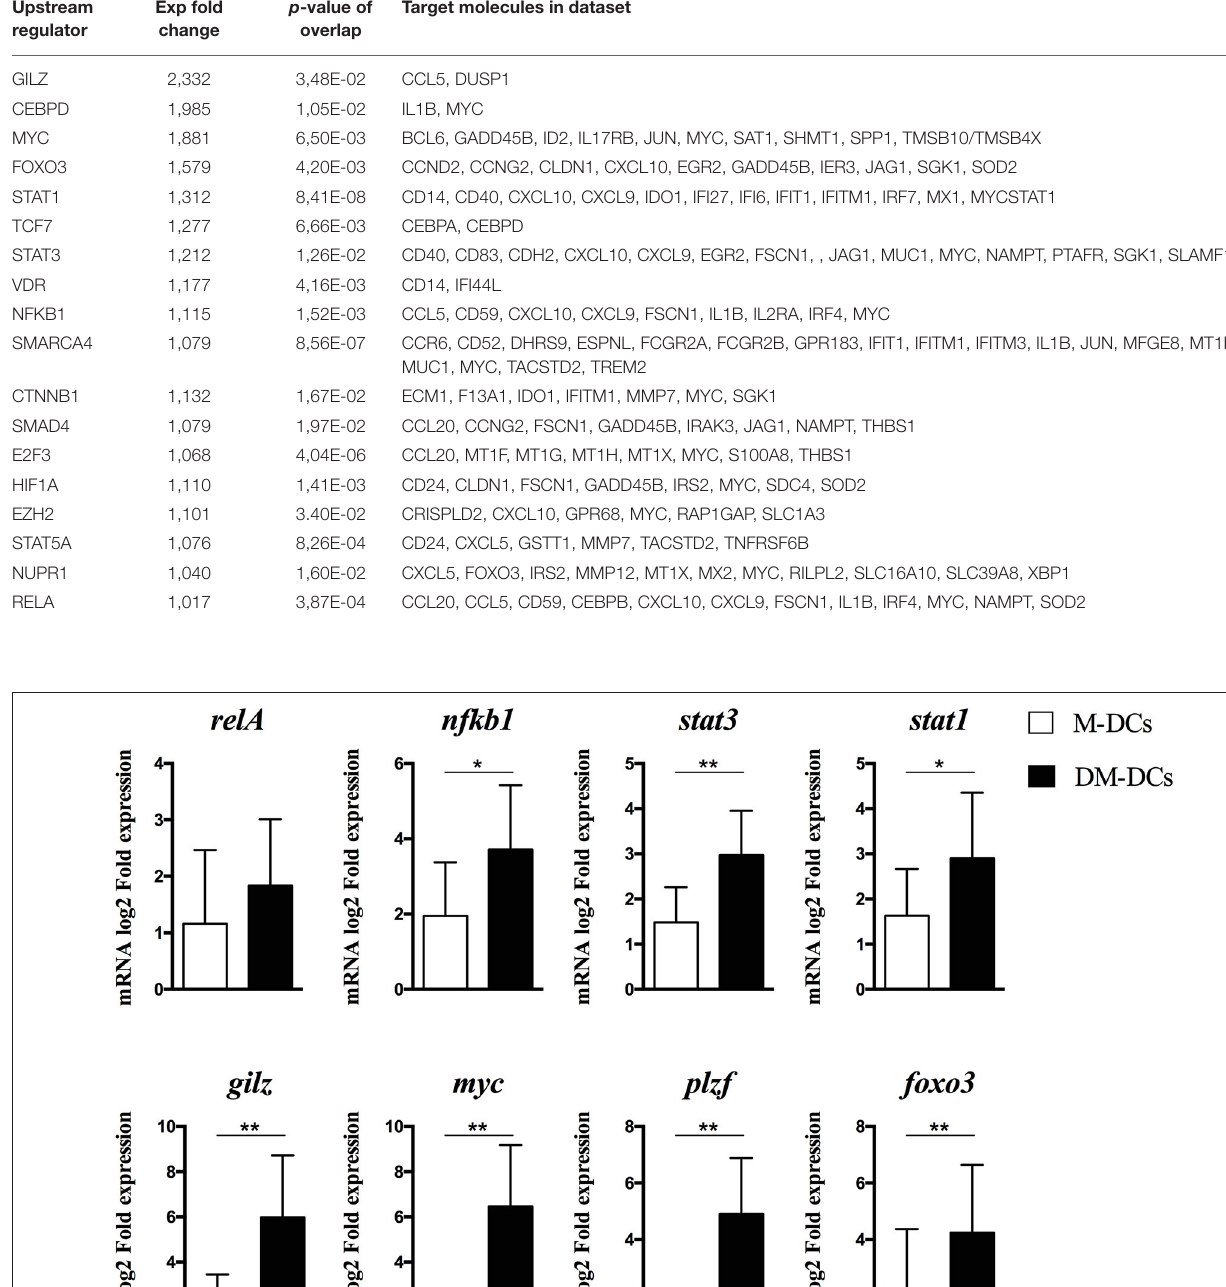
TABLE 1 | Main transcription factors identified as upstream regulators of differentially expressed genes in DM-DCs. p -value of Upstream Exp fold Target molecules in dataset regulator change overlap